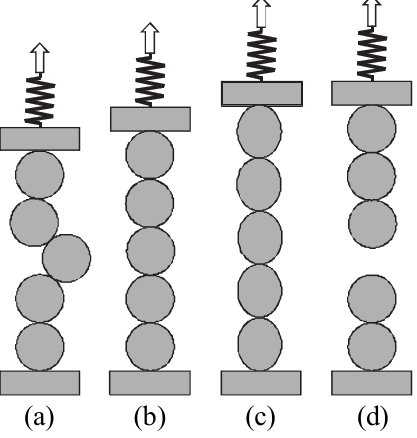
Fig. 4 Schematic of a chain of particles hold together by attractive forces. The bottom particle is rig- idly fixed to a substrate. With a stiff spring the top particle is moved